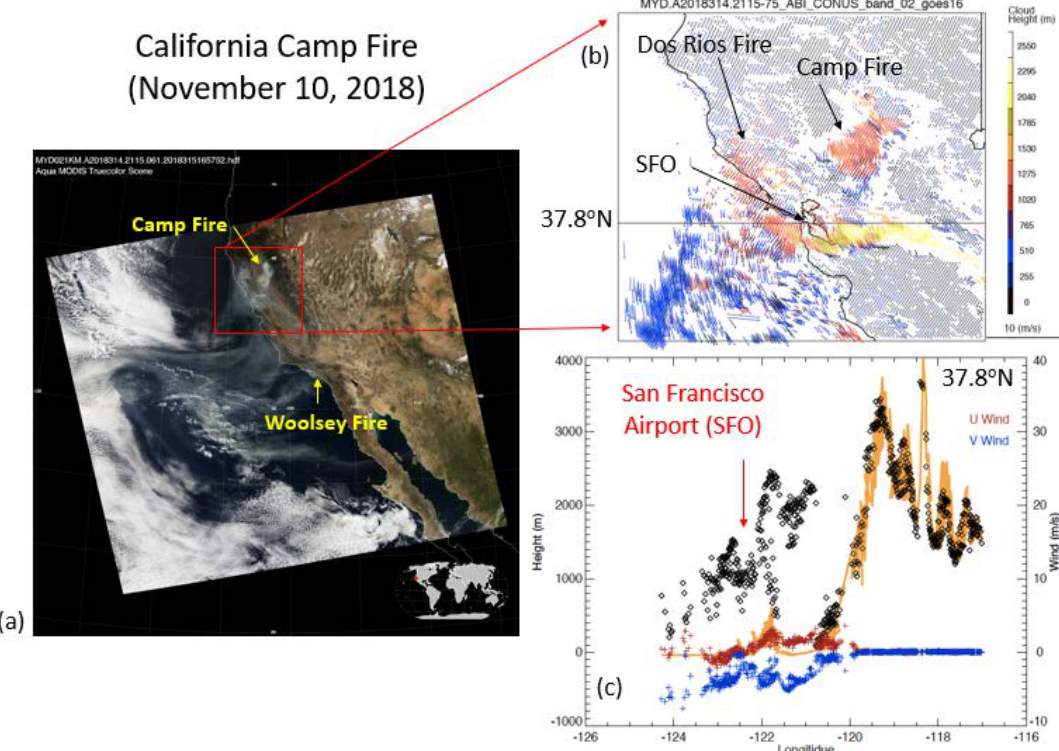
Figure 32. California camp fire and Woolsey fires ( a ) are shown as in Figure 31 but for November 10th. The cross-section ( c ) is at the latitude of SFO (37.8 °